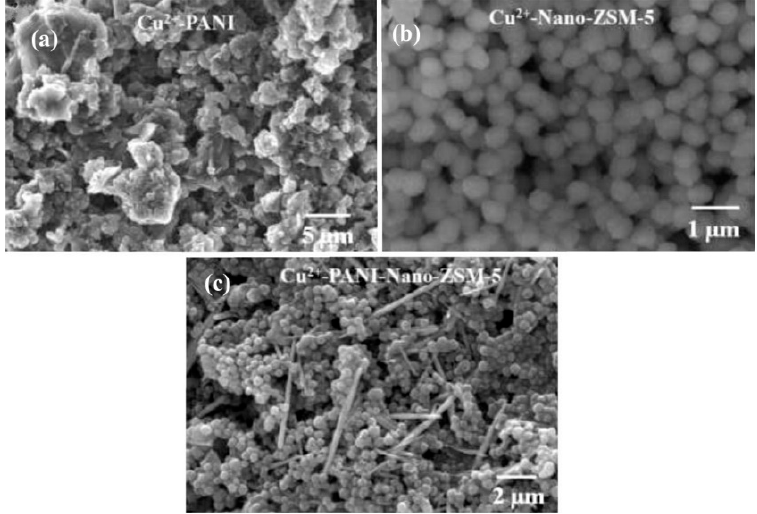
Figure 22. SEM images of ( a ) Cu 2+ -PANI, ( b ) Cu 2+ -Nano-ZSM-5, and ( c ) Cu 2+